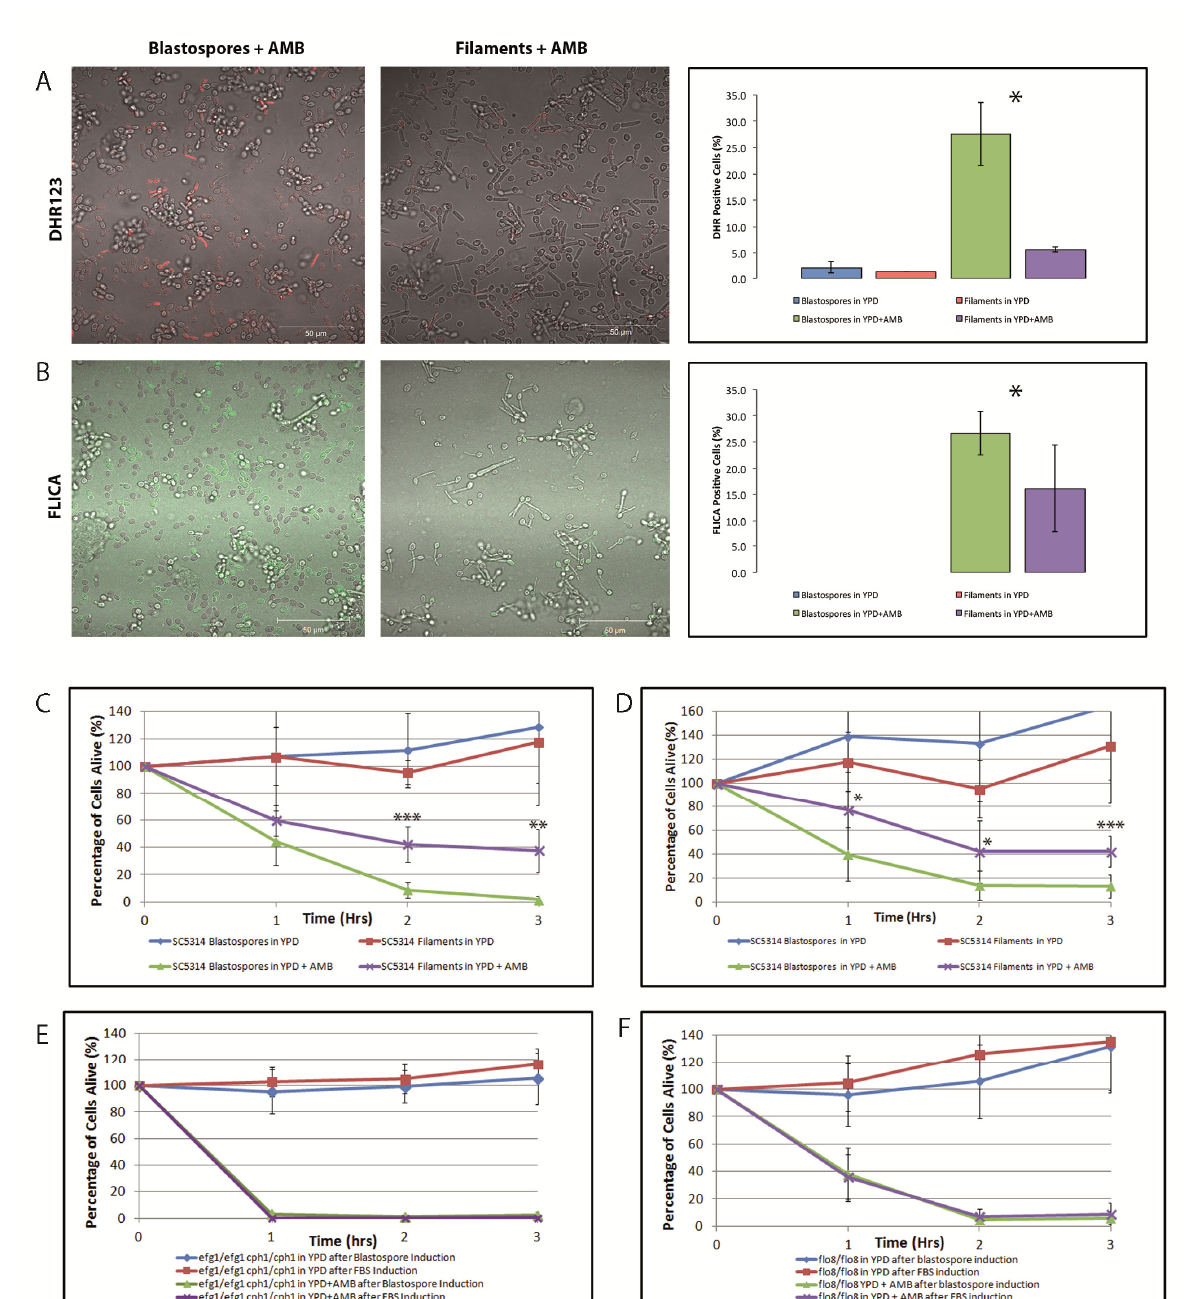
FIGURE 1: Filamentous C. albicans cells are more resistant than blastospores to AMB-induced programmed cell death. Exposure to ampho- tericin B leads to the generation of reactive oxygen species (ROS) and to caspase activation in C. albicans cells. Representative confocal scan- ning laser fluorescence images of wild-type SC5314 C. albicans cells treated with 8 μg/ml AMB for 3 hours in YPD. Staining with dihydrorhoda- mine 123 (DHR123) confirms the presence of ROS (A) and with the FLICA assay for activation of intracellular caspases (B) . Error bars indicate standard deviations for trials with at least three independent cultures, where at least 300 cells were counted for each trial. No FLICA positive cells were observed in the no drug controls. A single asterisk indicates statistical significance (p < 0.05) as compared to treated controls. Statis- tical significance was determined with the unpaired Student’s t-test. Scale bar: 50 μm. Viability curves compare survival of the following cells exposed to AMB: (C) wild type blastospores and wild type filaments induced using 10% FBS; (D) wild type blastospores and wild type filaments induced using 0.5 g/l GlcNAc; (E) ΔΔ efg1/efg1 cph1/cph1 cells in YPD and ΔΔ efg1/efg1 cph1/cph1 cells following filamentous induction in YPD + 10% FBS, and (F) ΔΔ flo8/flo8 cells in YPD and ΔΔ flo8/flo8 cells following filamentous induction in YPD + 10% FBS. Note that after 3 hr, cells cultured in rich media without any drugs were able to grow and to divide, hence the relative viability levels that are greater than 100%. Error bars indicate standard deviations for trials with at least three independent cultures. A single, double, and triple asterisk indicates a significance of p < 0.05, p < 0.005, and p < 0.0005, respectively, as compared to treated controls. Statistical significance was determined with the unpaired Student’s